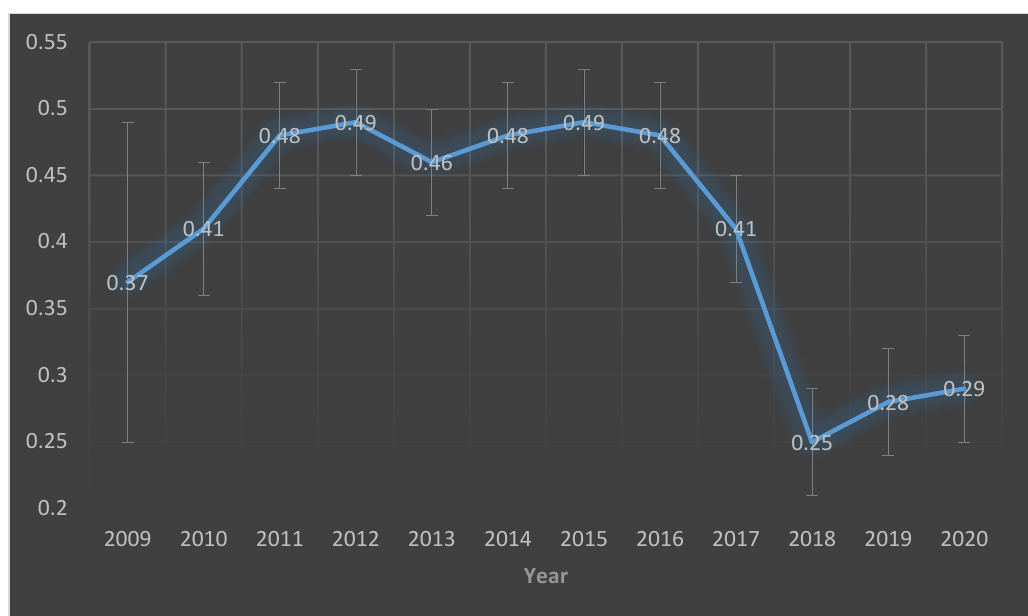
Figure 1. A longitudinal line plot of yearly prevalence of influenza A(H1N1)pdm09 virus infection in Norwegian pig herds obtained from the national active seroprevalence program 2009–2020. The 12% margin of error for year 2009 was much greater than the 4% for the other years because the disease outbreak occurred on 30 September 2009 leaving a smaller number (n = 54) of pig herds that were tested for the infection in 2009. A normal full year of sampling would involve ~500 pig herds.